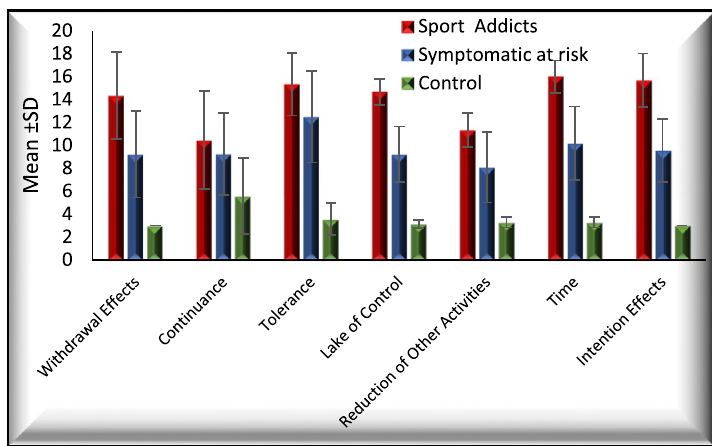
Fig. 3 Results of the 7 components of “Exercise Dependence Scale‑21 Manual”